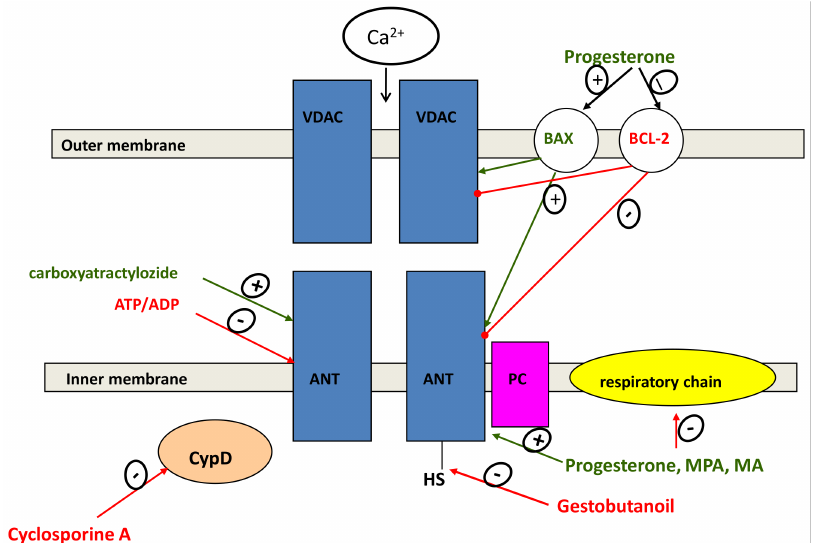
Figure 2. Influence of progesterone and progestins on MPTP opening. Progesterone and progestins decrease the expression ofBcl-2 and increase the expression of Bax, promoting MPTP opening. Cyclosporine A and ADP/ATP prevent MPTP opening via interaction with cyclophillin D and ANT, respectively. Progesterone, MPA and MA activate MPTP opening, and GB inhibits MPTP opening induced by calcium ions and pro-oxidants by decreasing or increasing their threshold concentration. The influence of GB is prevented by CAT, which indicates the participation of ANT in this